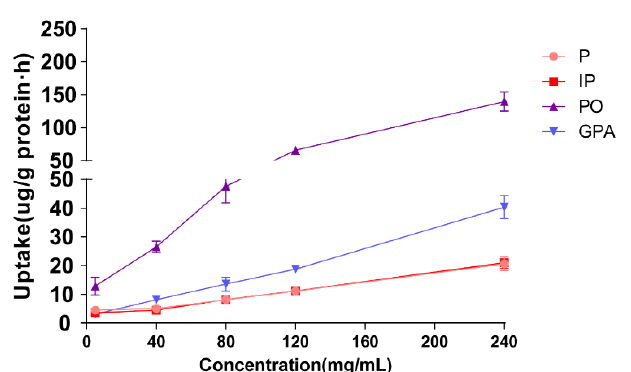
Figure 3. Cellular uptake of the 4 component compounds of various drug-contained medium of extracts of Qing’e Pills at different concentrations.